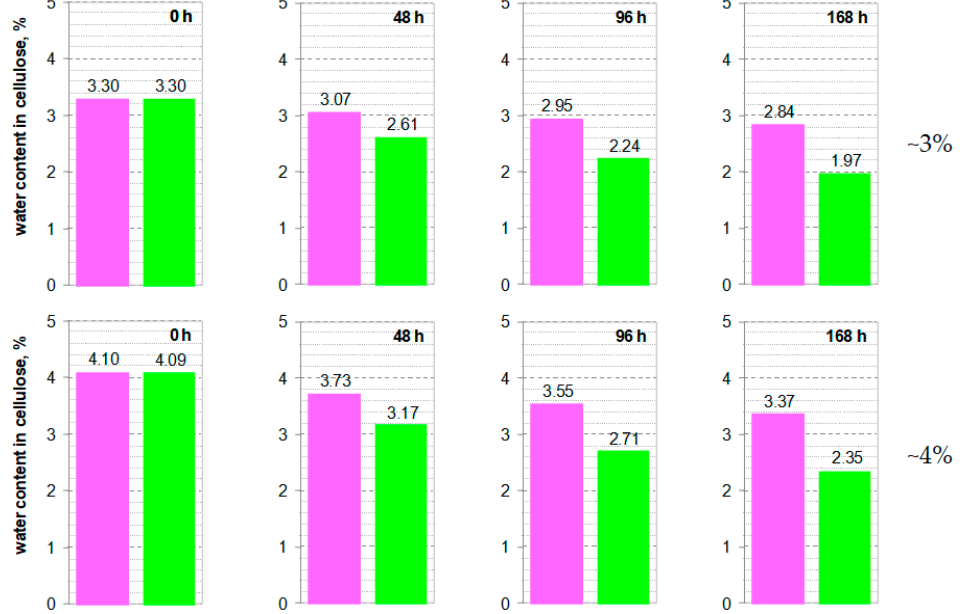
Figure 13. Cellulose moisture in the drying process depending on the drying time—comparison for the worst (pink color: 220 ppm, 55 °C) and best (green color: 70 ppm, 85 °C) drying process conditions; initial moisture of cellulose ~3% and ~4%, thickness of samples 3 mm, mass ratio of cellulose to ester 0.067.